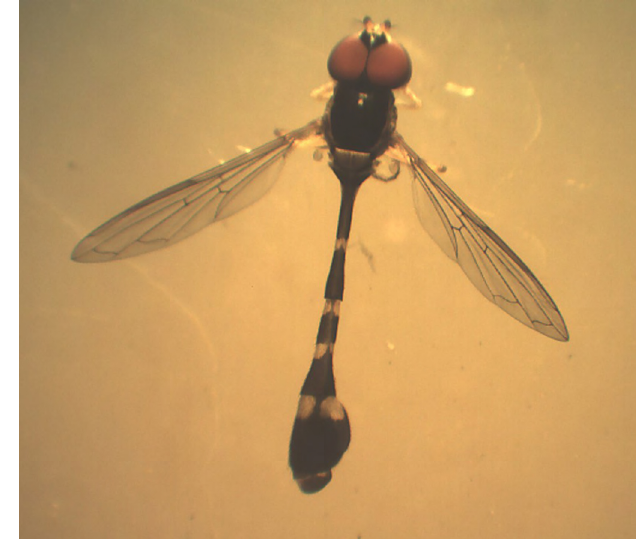
Figure 5. Nipaecoccus coffeae : two sizes of dorsal oral collars Figure 6. Ocyptamus stenogaster (Diptera, Syrphidae), predator of the Nipaecoccus coffeae.